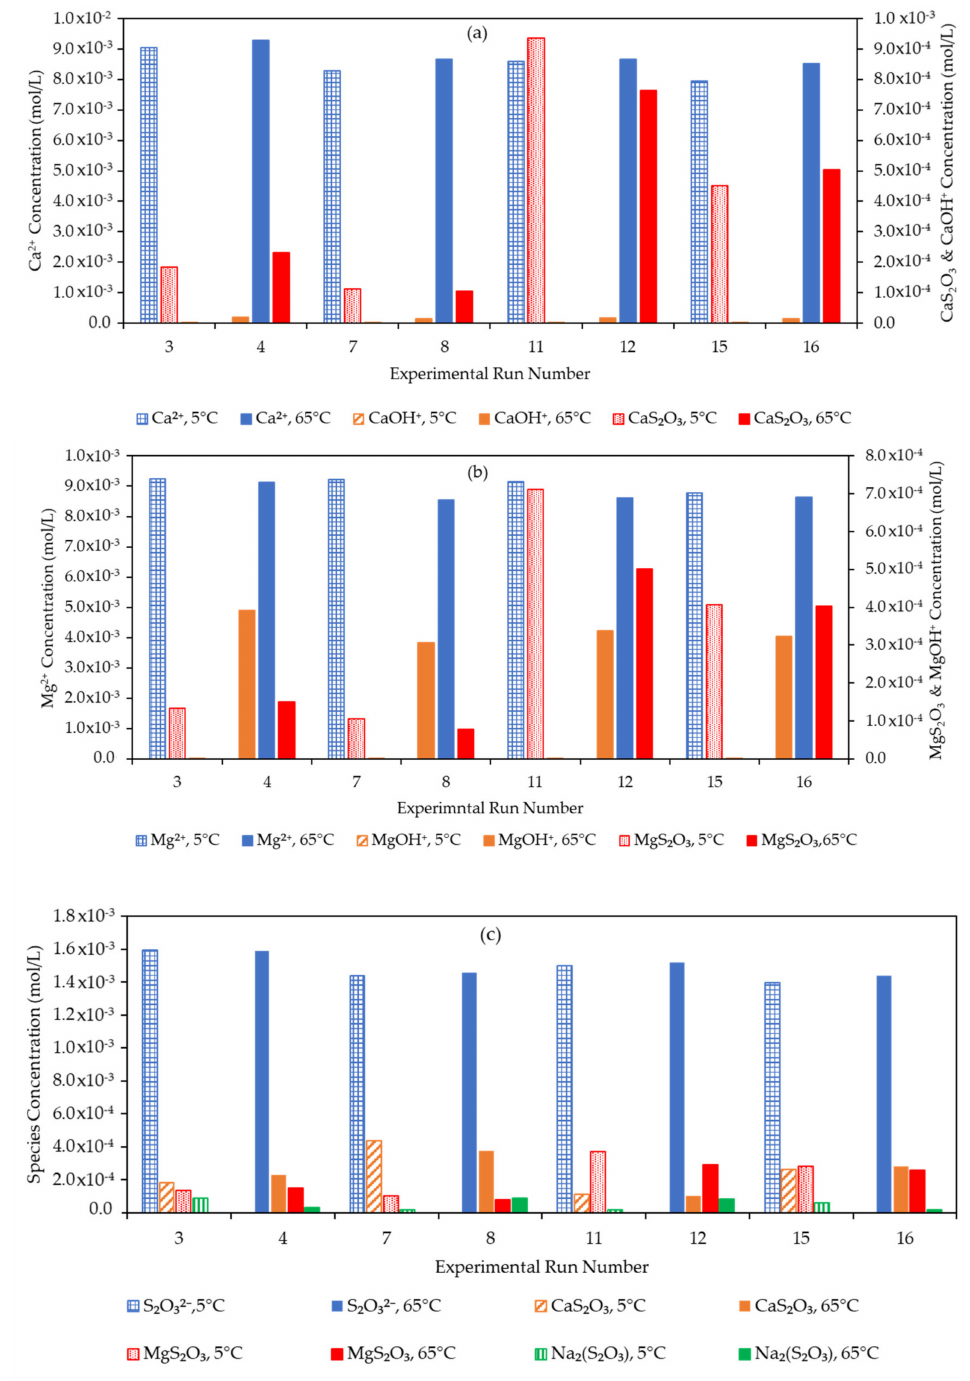
Figure 7. ( a ) Distribution of Ca 2 + after interaction in di ff erent water matrices at pH 9. Starting Ca 2 +